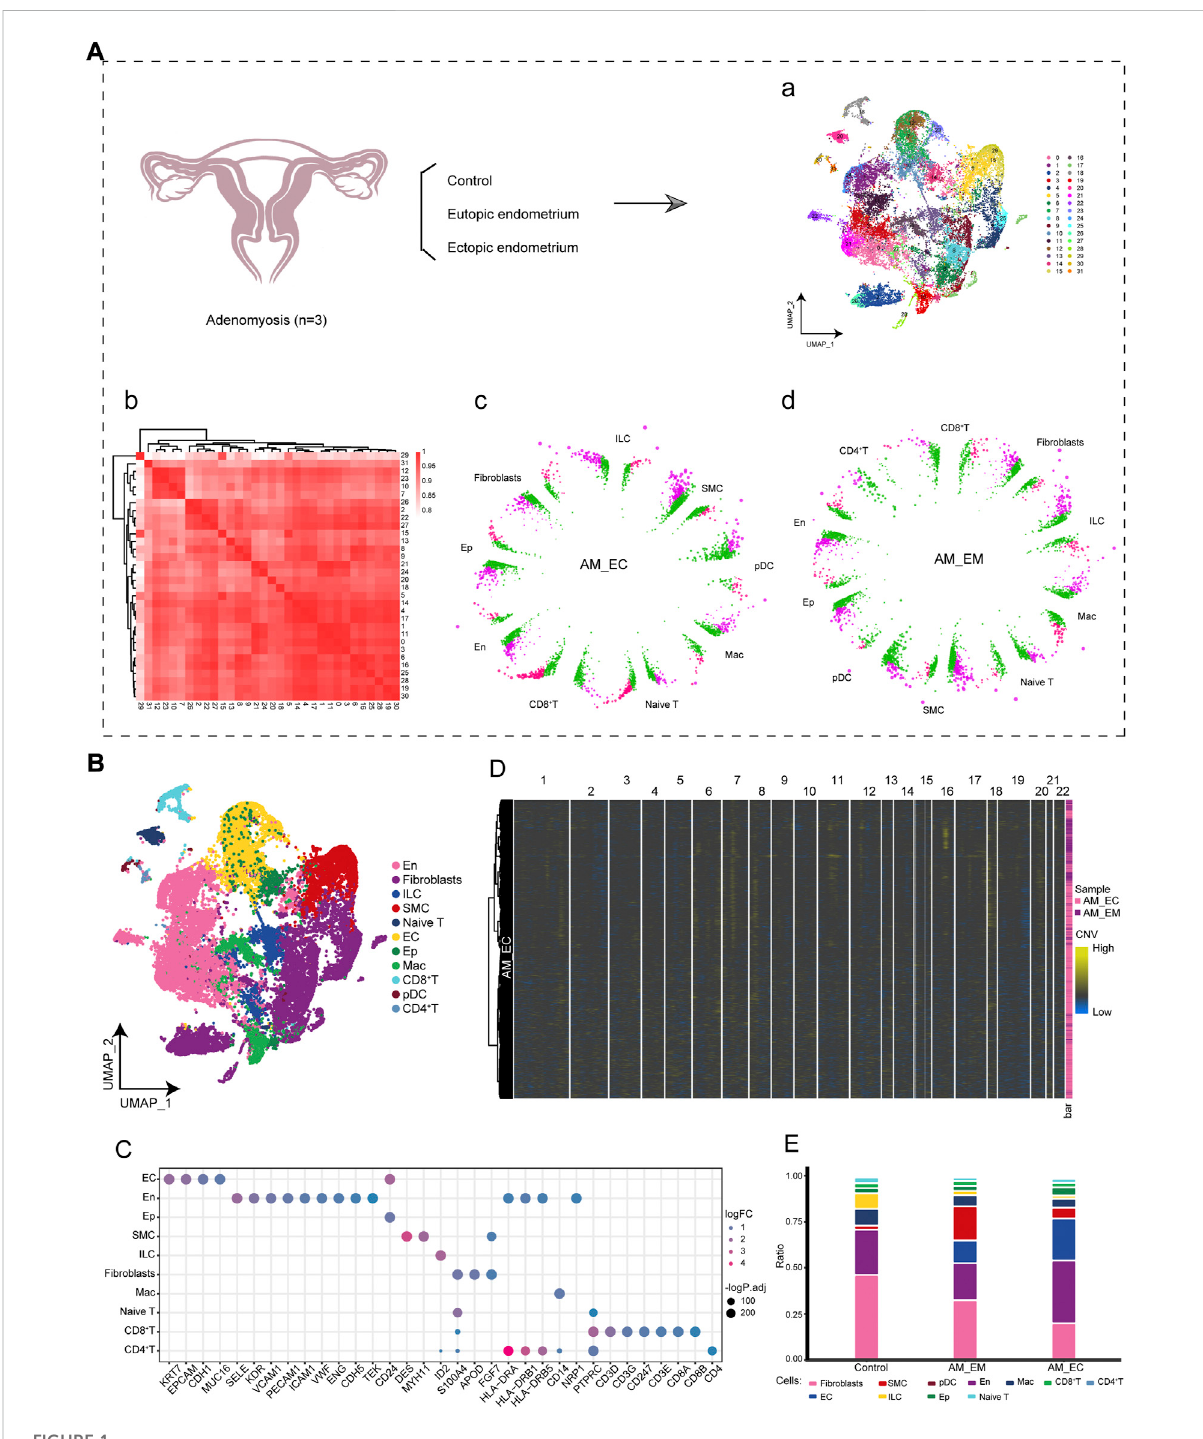
FIGURE 1 Single-cell landscape of adenomyosis (AM) in the immune microenvironment. (A) . The work fl ow of this study analyzed single-cell RNA sequencing (10X Genomics) data between control and two AM between eutopic endometrium (AM_EM) and ectopic endometrium (AM_EC) samples, identifying 31 cell clusters of 42,260 cells. (B). The cell types of single cells mapping AM includes endometrial cells (EC), fi broblasts (Fibroblasts), epithelial cells (Ep), endothelial cells (En), CD8 + T, CD4 + T, initial T cells (Naive T), macrophages (Mac), predendritic cells (pDC), smooth muscle cells (SMC), and innate lymphoid cells (ILC). (C) . Bubble plots show speci fi cmarker genes in different cell types. (D). Heatmap shows the levels of copy number variation in chromosomes 1 to 22 during AM. (E). Differences in cell abundance components between control and AM patients. Different colors represent different cell types. AM_EM, eutopic endometrium; AM_EC, ectopic endometrium; CNV, copy number variations; EC, endometrial cells; Ep, epithelial cells; En, endothelial cells; Naive T, initial T cells; Mac, macrophages, pDC, predendritic cells; SMC, smooth muscle cells; ILC, innate lymphoid cells; UMAP, Uniform Manifold Approximation and